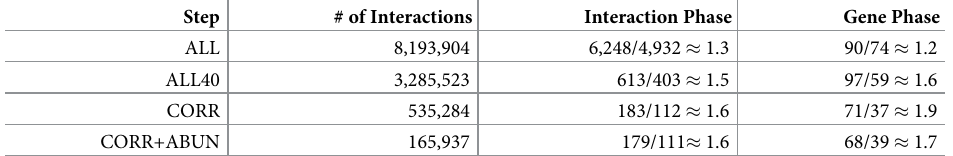
Table 3. Evaluation of miRNA-target interaction filtering steps for the computed miRNA-target interactions using miRNA transfection data. Step # of